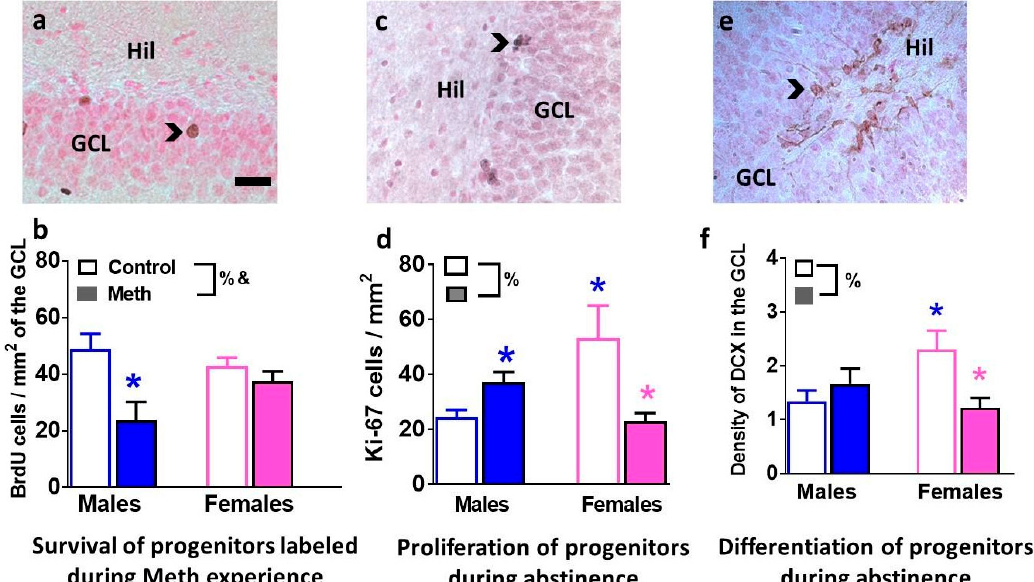
Figure 2. Developmental stages of neurogenesis in the dentate gyrus (DG) are distinctly altered in males and females. ( a , c , e ) Photomicrographs of BrdU ( a ), Ki-67 ( c ) and doublecortin (DCX) ( e ) from one control male rat. Arrowhead points to immunoreactive cells in each panel. Hil, Hilus; GCL, granule cell layer. Scale bar in ( a ) is 20 µ m, it applies to a, c, e. ( b , d , f ) Quantitative analysis of BrdU ( b ), Ki-67 ( c ) and DCX ( e ). Data are represented as mean ± S.E.M. n = 4–19 males, n = 4–13 females. %, significant sex × reinstatement interaction; &, main effect of reinstatement; * p < 0.05 vs. control males; * p < 0.05 vs. control females.